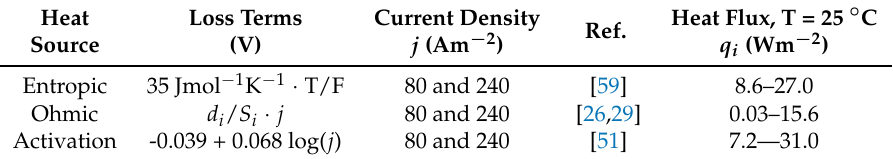
Table 3. Heat sources used in the developed model.